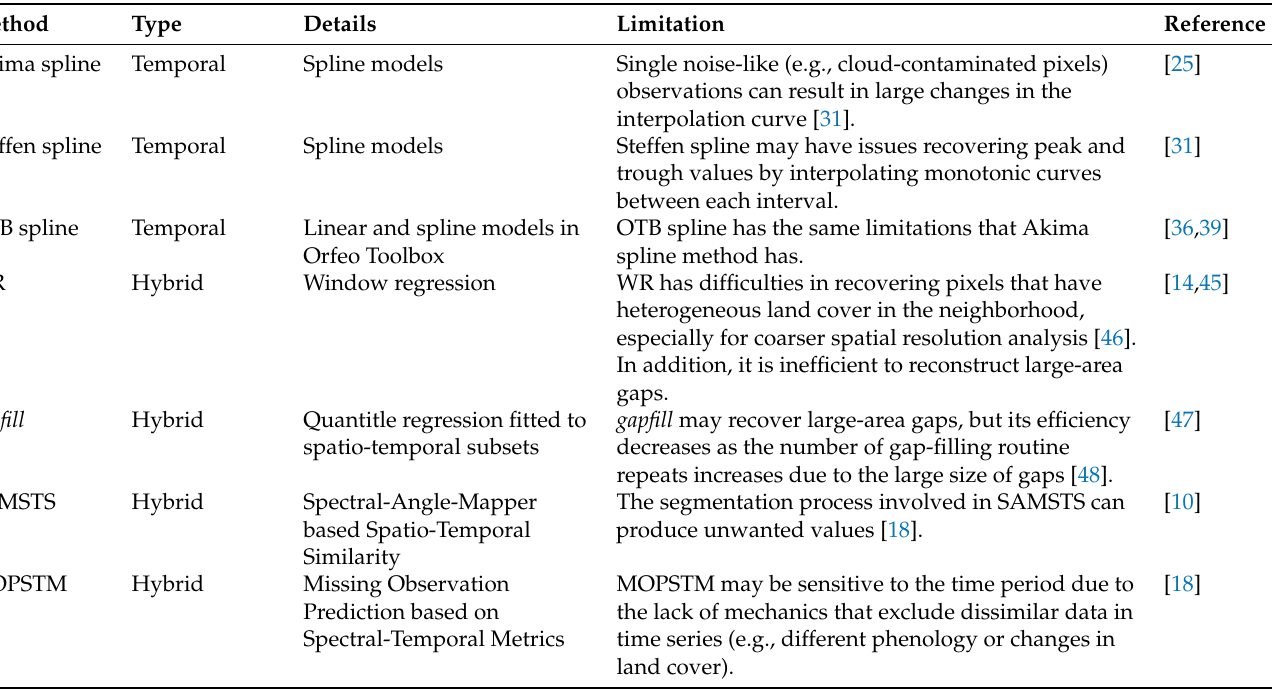
Table 1. Limitations of the state-of-the-art gap-filling methods that have been compared in this